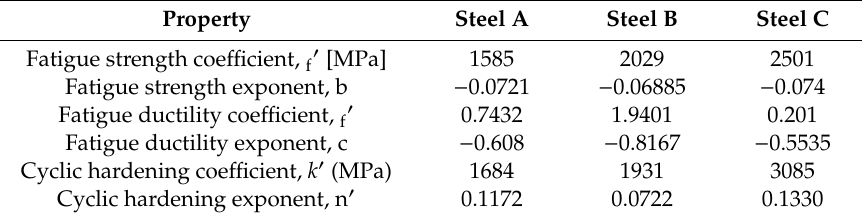
Table 3. Low-cycle fatigue properties of the tested steels (Data from [9]). Property Steel